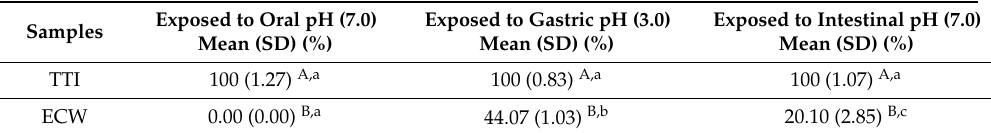
Table 1. Comparison of the percentage of antitrypsin activity between ECW and TTI exposed to different conditions of pH and time.